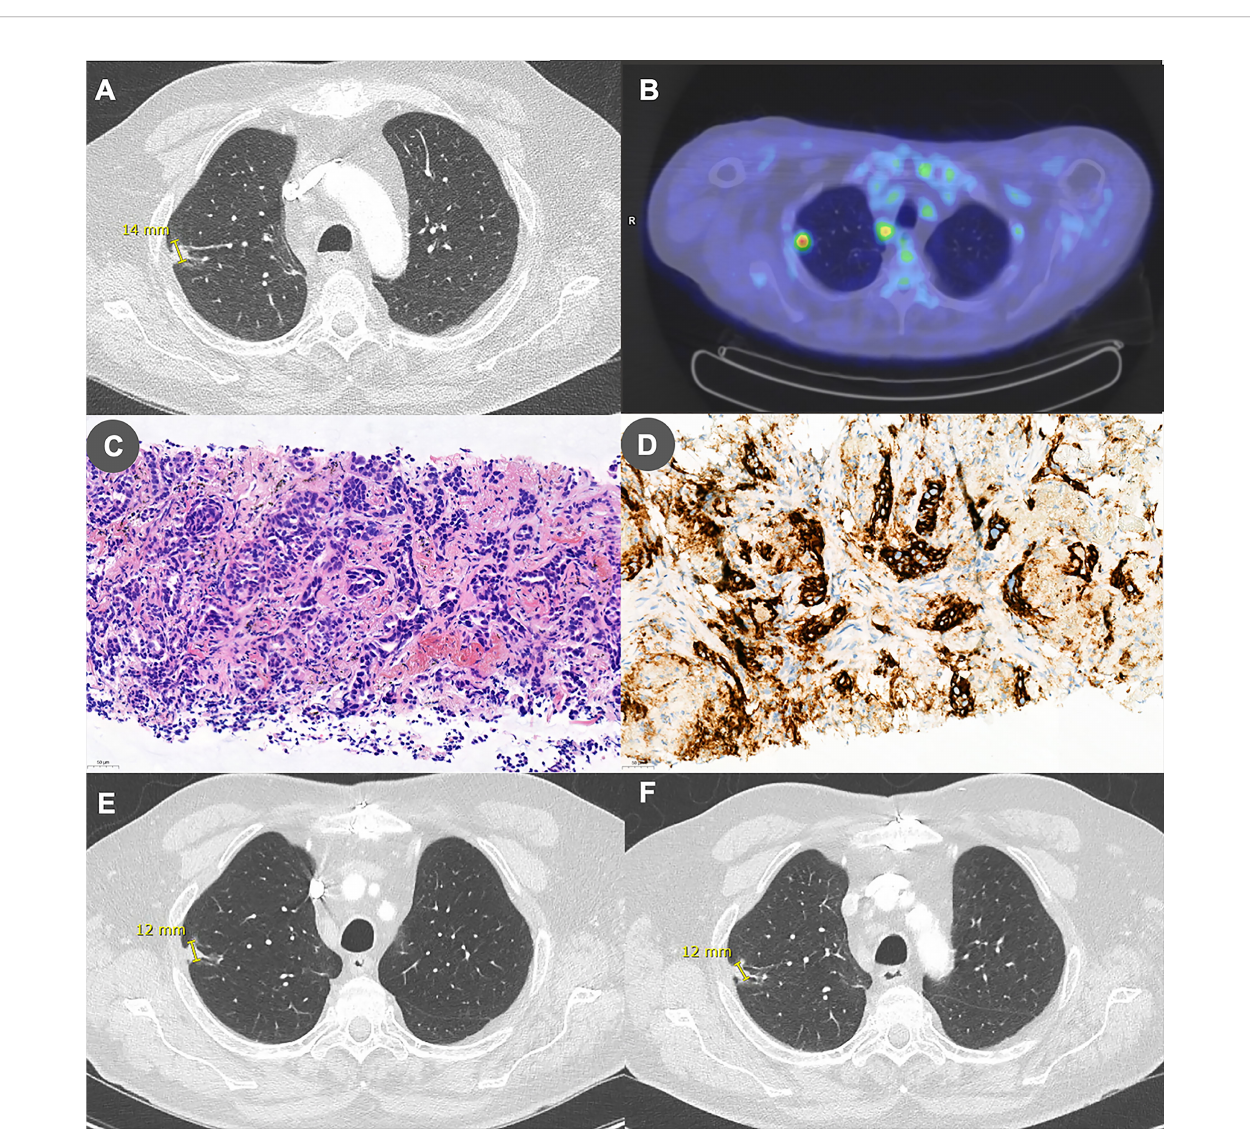
FIGURE 2 | Panel (A) Chest CT performed before treatment initiation showing a 14-mm right upper lobe irregular nodular lesion. Panel (B) This lesion was found to be hypermetabolic on [ 18 F]- fl uorodeoxyglucose positron emission tomography. Panel (C) Lung biopsy specimen showing a modi fi ed fi brous tissue in fi ltrated by irregular and rami fi ed tubuloacinar structures formed by non-small neoplastic cells with hyperchromatic nucleus and weakly eosinophilic cytoplasm. The overall appearance is compatible with a lung adenocarcinoma (hematoxylin-eosin stain, 200x). Panel (D) PD-L1 is expressed by 50% of tumor cells (PD-L1 immunoperoxydase, 200x). Panels (E, F) Chest CT performed (E) 6 months and (F) 1 year after treatment initiation showing stability of the